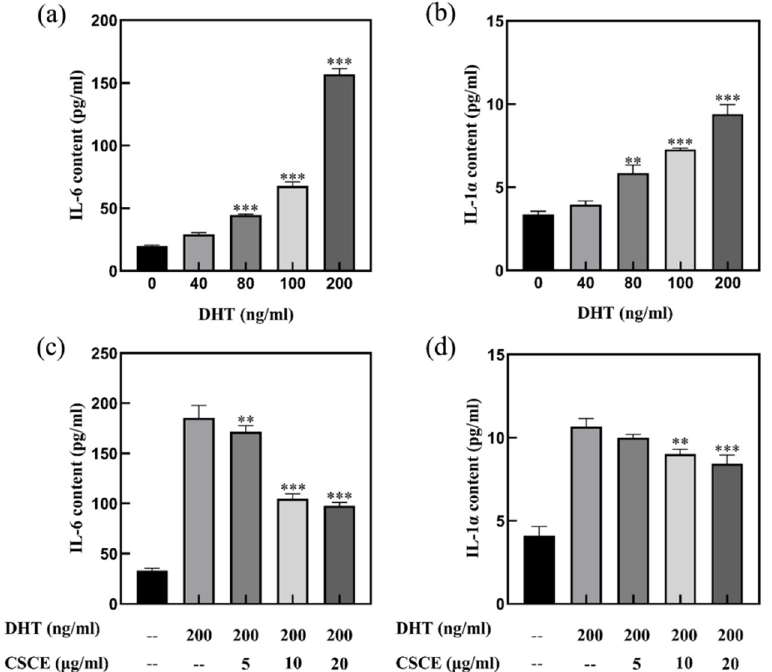
Figure 3. DHT induced the release of IL-6 ( a ) and IL-1 α ( b ) inflammatory factors in DPCs, and the induction activity was inhibited by CSCE ( c , d ). (Compared with blank control group, ** p < 0.01, *** p < 0.001).